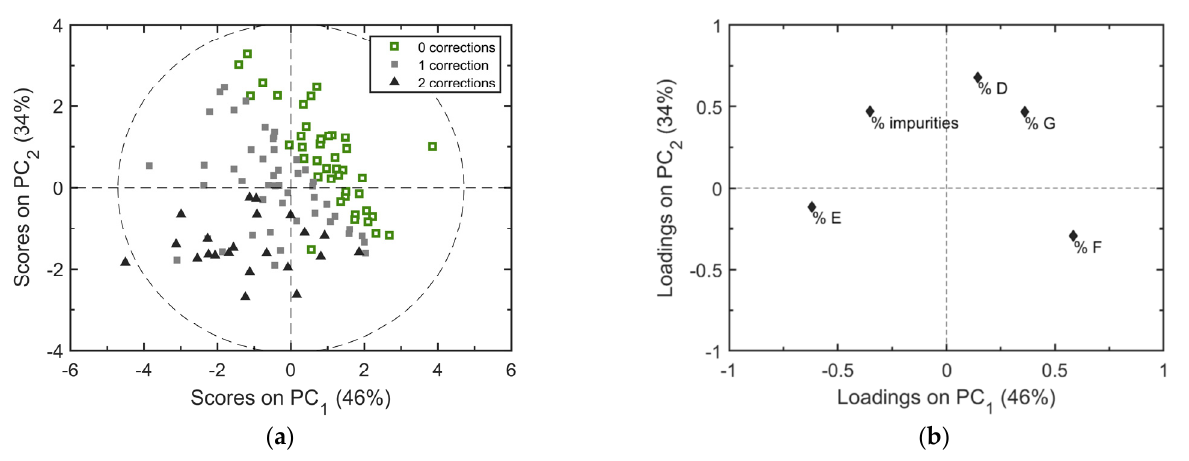
Figure 4. Results of a two-component principal component analysis (PCA) model built on the product quality data matrix (R203): ( a ) scores plot with indication of the batches resulting in 0, 1, or 2 corrections; ( b ) loadings plot.